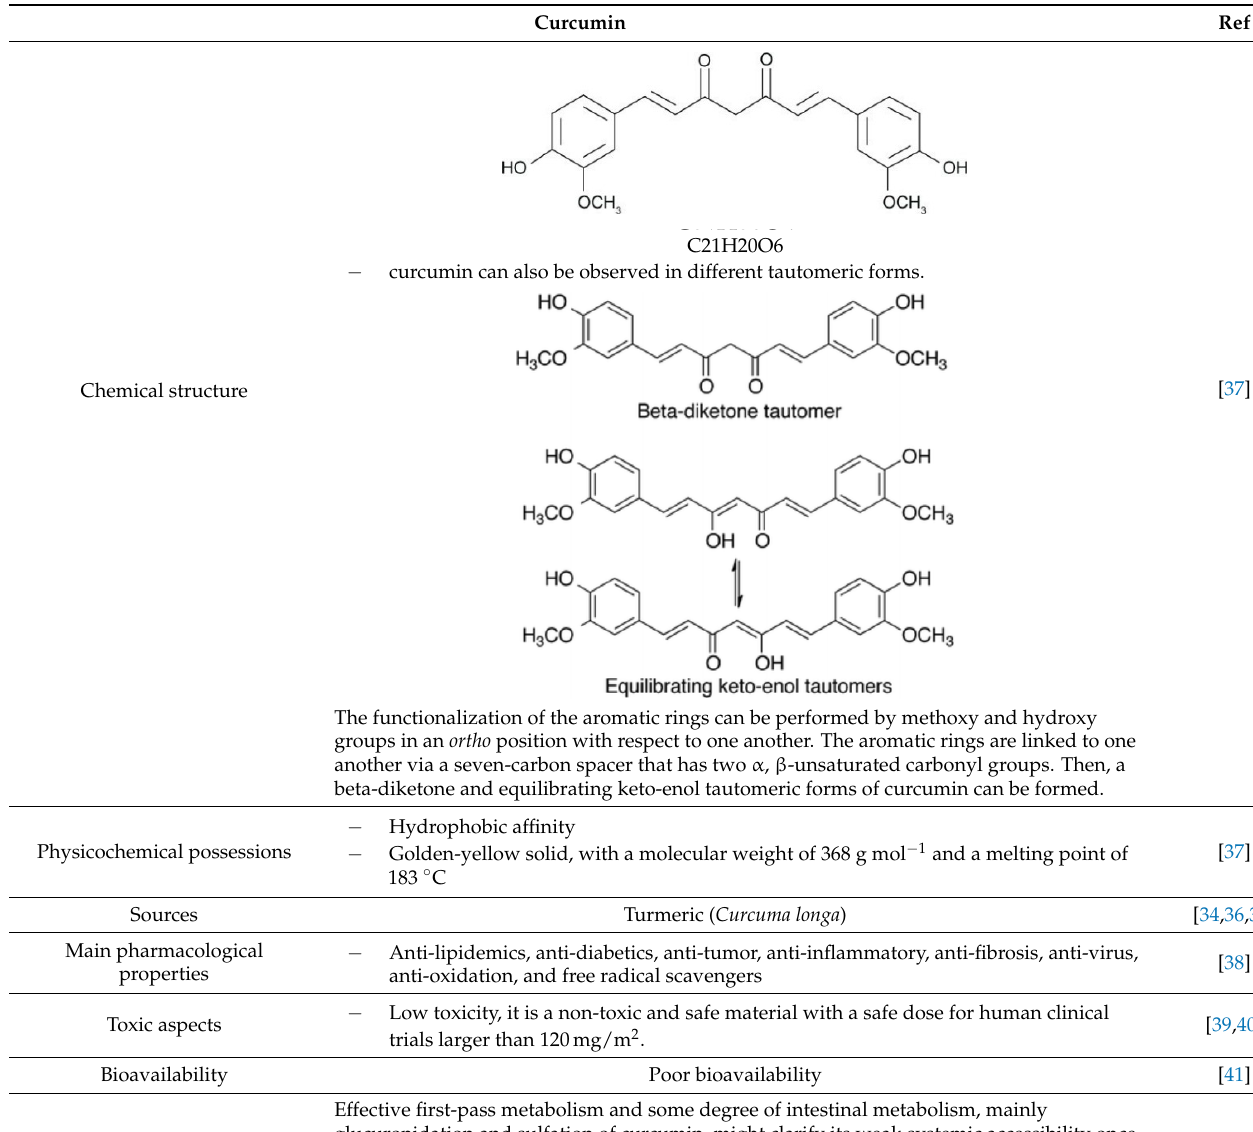
Table 1. Main characteristics of curcumin.